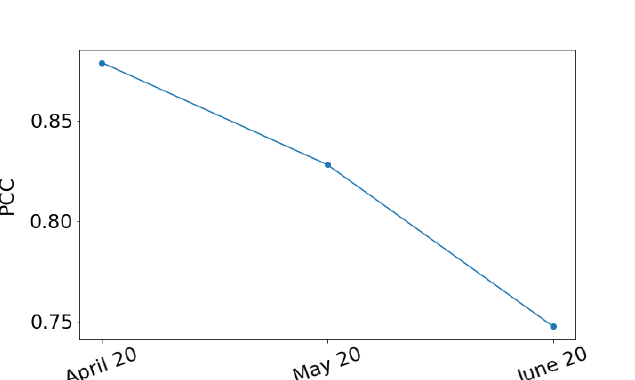
Figure 12. PCC for different the timesteps predicted images and the timesteps true images as a function of the last month of the timesteps predicted images.